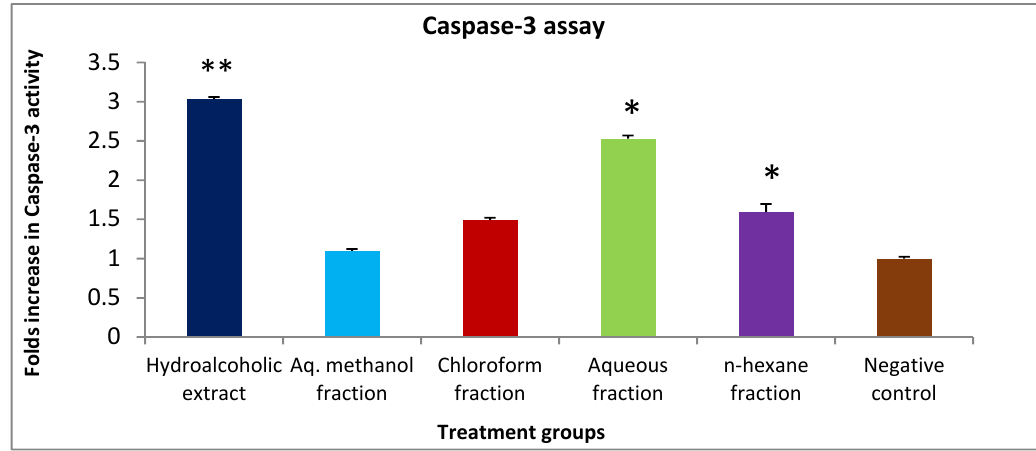
Figure 2. The effect of IC ₅₀ concentration of H. orientalis L. extract and fractions on caspase-3 expression in T47D cell line. Concentration of the extracts: hydroalcoholic (6.12 mg/mL), aqueous methanol (0.11 mg/mL), chloroform (3.53 mg/mL), aqueous (11.38 mg/mL), and n -hexane (0.59 mg/mL) (* p < 0.05, ** p < 0.001 compared to the negative control). Results are expressed as means of three independent experiments (bars) ± SEM (lines).